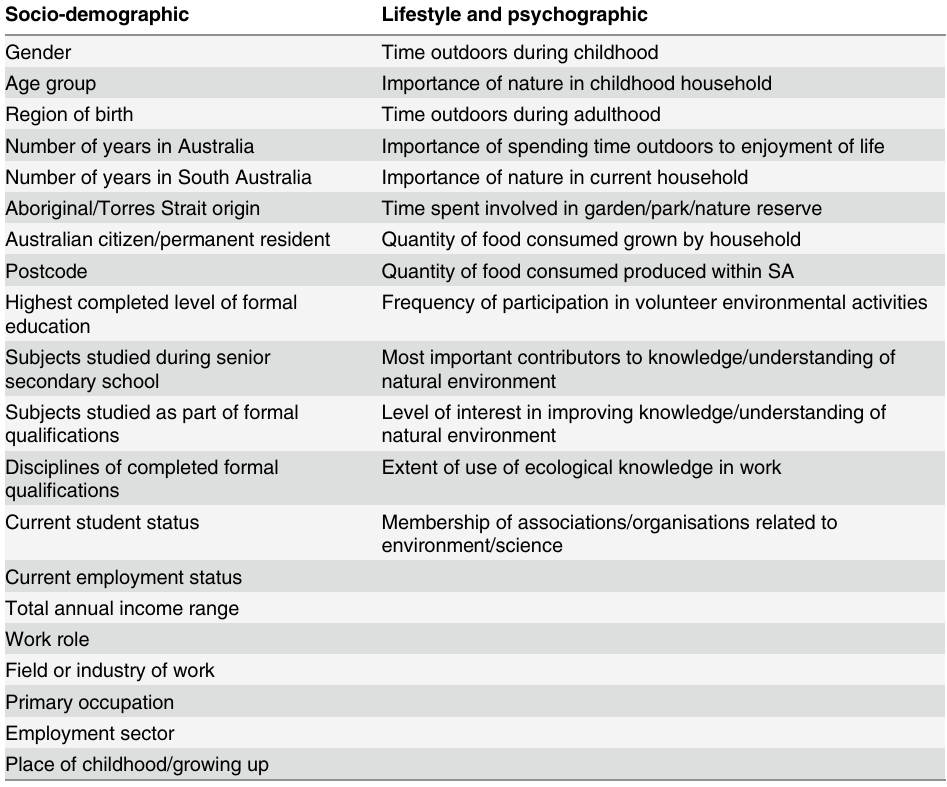
Table 1. Summary of the focus of socio-demographic and psychographic survey questions.